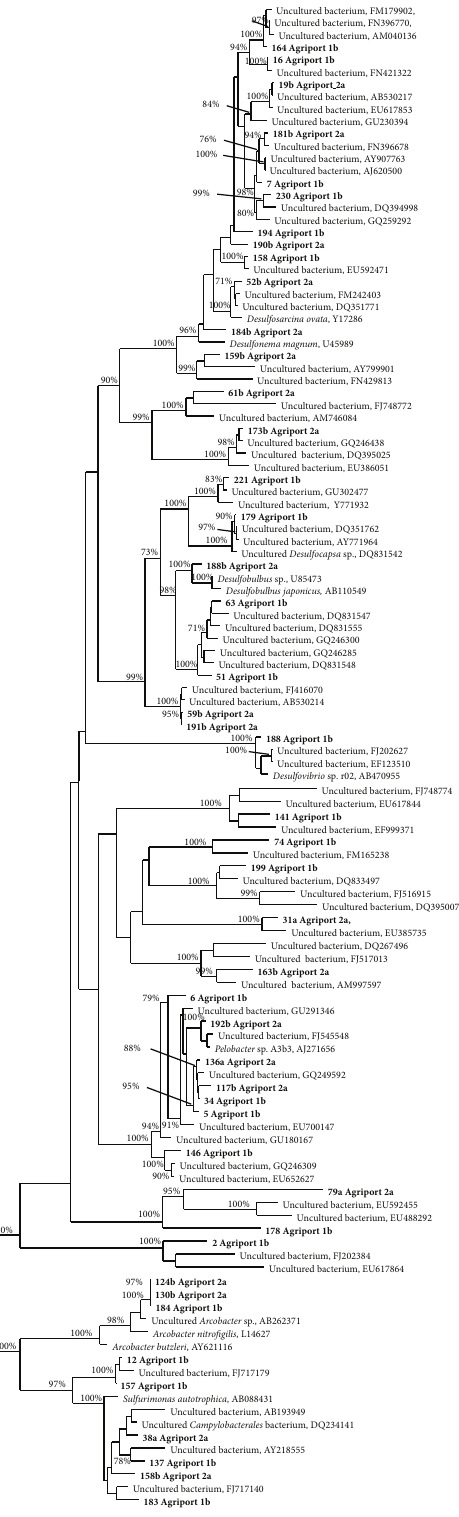
Figure5:MaximumlikelihoodphylogenetictreemadewithPHYMLand100bootstrappseudoreplicates.Thetreerepresentsthephylogenetic position of characterized Delta- and Epsilonproteobacteria clone sequences together with closely related sequences present in the database. The characterized sequences are in